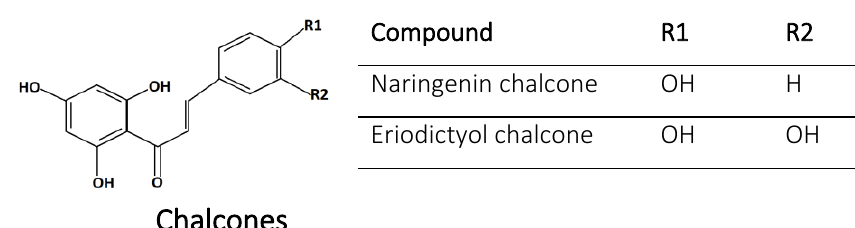
Figure 8. Chalcones: chemical structure, types and substitution positions in the basic skeleton.